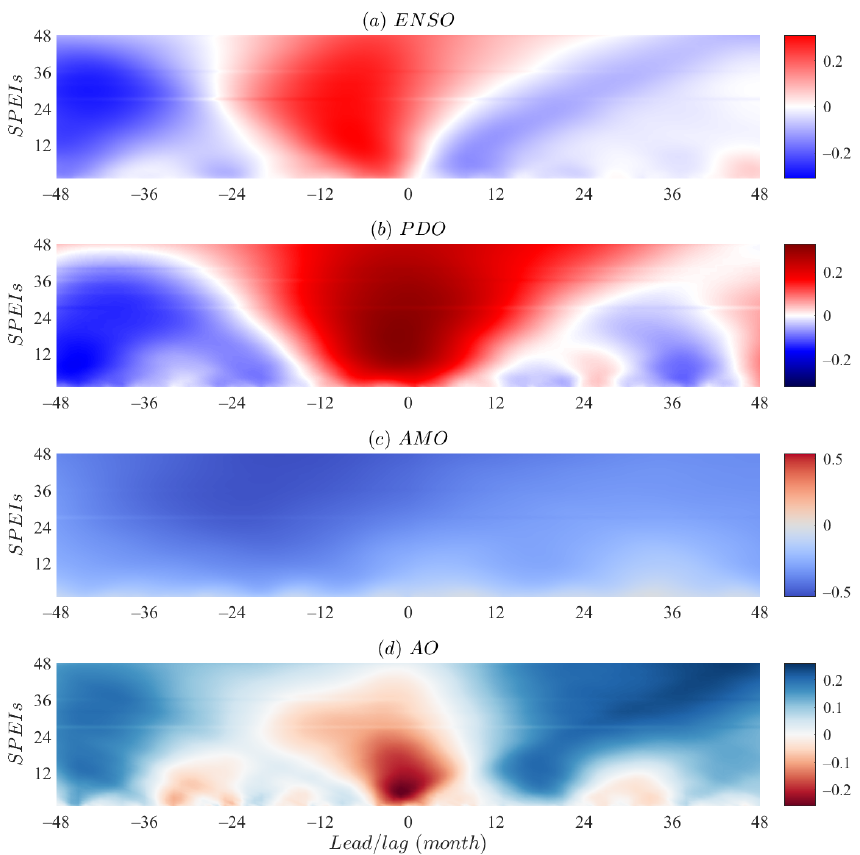
Figure 7. Cross-correlation coefficients of Xinjiang SPEIs to ( a ) ENSO, ( b ) PDO, ( c ) AMO, and ( d ) AO on 1- to 48-month time scales during 1951–2020 with considering lead and lag for 48 months. Horizontal axis represents lead/lag month, and vertical axis represents SPEI at different time scales. On the horizontal axis, − k (+k) indicates that SPEI leads (lags) the climate index by k